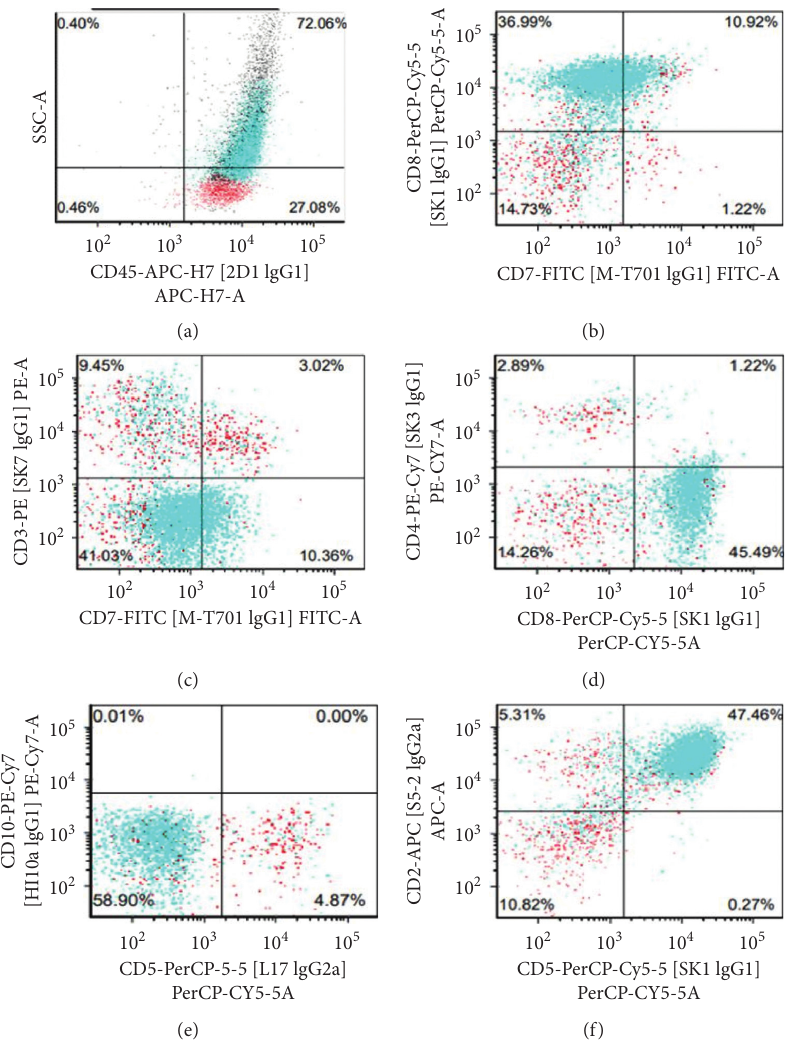
Figure 1: Flow cytometry of the lymph node showing atypical T cells positive for CD2, CD7 (dim), and CD8, with negative surface CD3, CD4, and